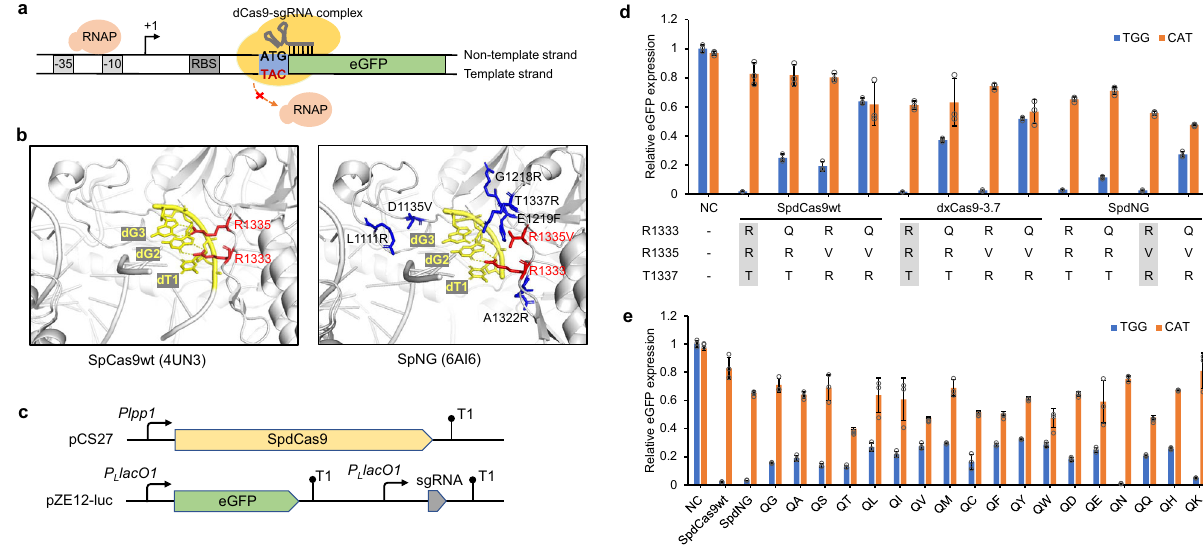
Fig. 1 Generation of dCas9 variants targeting 5 ′ -CAT-3 ′ protospacer adjacent motif (PAM) sequence. a Inhibition of transcription elongation from RNA polymerase (RNAP) when SpdCas9 variant was targeted to the start codon ATG of target genes. SpdCas9 variant recognizing 5 ′ -CAT-3 ′ PAM sequence could bind at the start codon ATG, with sgRNA spacer complementary to the ATG adjacent sequence (20 bp) on the nontemplate DNA strand. The -35 and -10 boxes, and ribosome binding site (RBS), are shown in gray. + 1, transcription initiation site. b PAM-interacting (red) or proximal residues (blue) in SpCas9wt (PDB ID: 4UN3) and SpNG (PDB ID: 6AI6). PAM sequence is shown in yellow. c The dual-plasmid eGFP repression system for SpdCas9 variant characterization: pCS27 containing Plpp1 -controlled SpdCas9wt or variants and pZE12-luc containing P L lacO1 -controlled eGFP and sgegfp-TGG or sgegfp- CAT. d Impact of mutating PAM interaction residues (R1333/R(V)1335/T(R)1337) in SpdCas9wt, dxCas9-3.7, and SpdNG on 5 ′ -TGG-3 ′ (blue) and 5 ′ -CAT-3 ′ (orange) PAM recognition. The residues in shaded boxes correspond to residues in unmutated SpdCas9wt, dxCas9-3.7, and SpdNG, respectively. e Impact of combinatorial mutations of R1333/V1335 in SpdNG on 5 ′ -TGG-3 ′ (blue) and 5 ′ -CAT-3 ′ (orange) PAM recognition. NC, E. coli BW25113(F ′ ) cotransformed with the empty pCS27 plasmid and pZE-eGFP-sgegfp-TGG or pZE-eGFP-sgegfp-CAT. Data indicated the mean ± standard deviation ( n = 3 independent biological replicates). Source data are provided as a Source Data fi